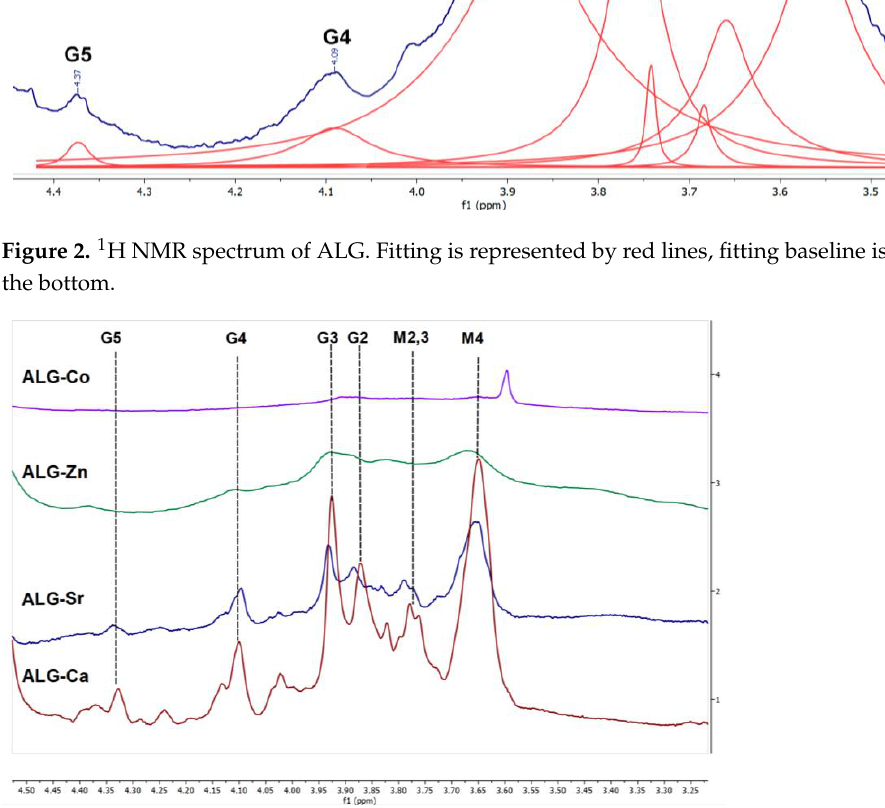
Figure 3. 1 H NMR spectra of alginate cross-linking by Ca, Sr, Zn, and Co ions.